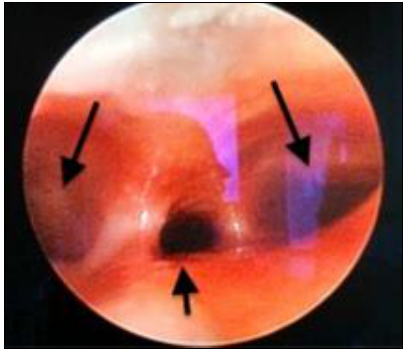
Figure 3: Bronchoscopy showing fistula opening at carina (small arrow) between left and right main bronchi (bigger arrows)